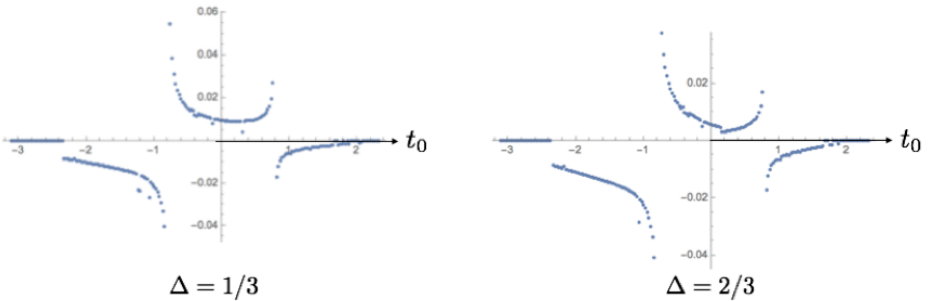
Figure 7 . Plots of Averaged null energies on null geodesics when the theory is deformed by bulk double trace deformation. The null geodesic starts at boundary of AdS with (cid:18) = (cid:25) and t = t 0 , then ends at AdS boundary with (cid:18) = 0 and t = t o + (cid:25) . Averaged null energy is divergent and we regularized it using a de(cid:12)ned in appendix A. The averaged null energy is proportional to g and a the plot is describing the coe(cid:14)cient of g . Note that on any null geodesic incoming from (cid:18) = (cid:25) and a (cid:0) (cid:25) < (cid:18) < 0, null energy is negative, when g is positive. This behavior is (cid:1) independent. sign of g is positive, averaged null Energy is negative for (cid:0) 3 (cid:25)= 4 < t < (cid:0) (cid:25)= 4 for any 0 (cid:1). So the null ray emitted into bulk in this period gets time shift and becomes